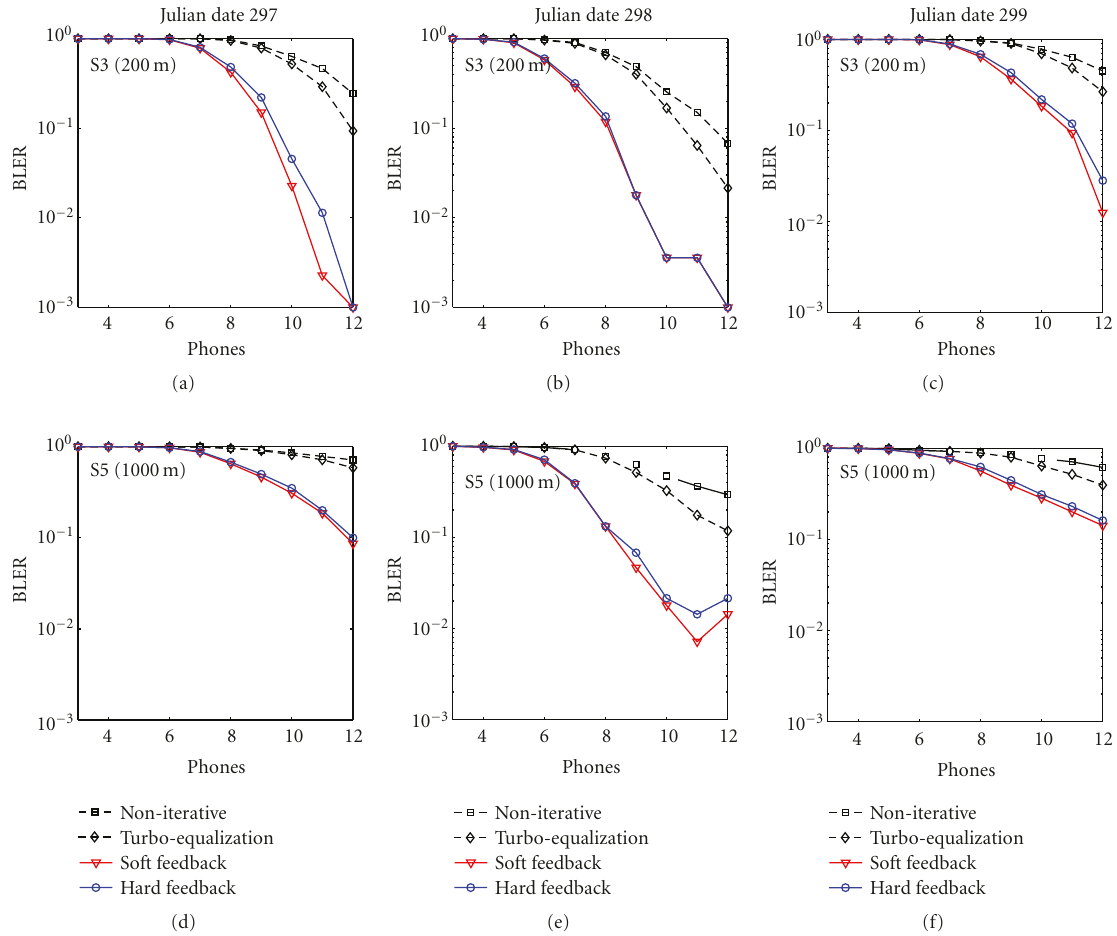
Figure 10: Experimental results from the SPACE08 experiment with N t = 3, QPSK, for S3 (200m) and S5